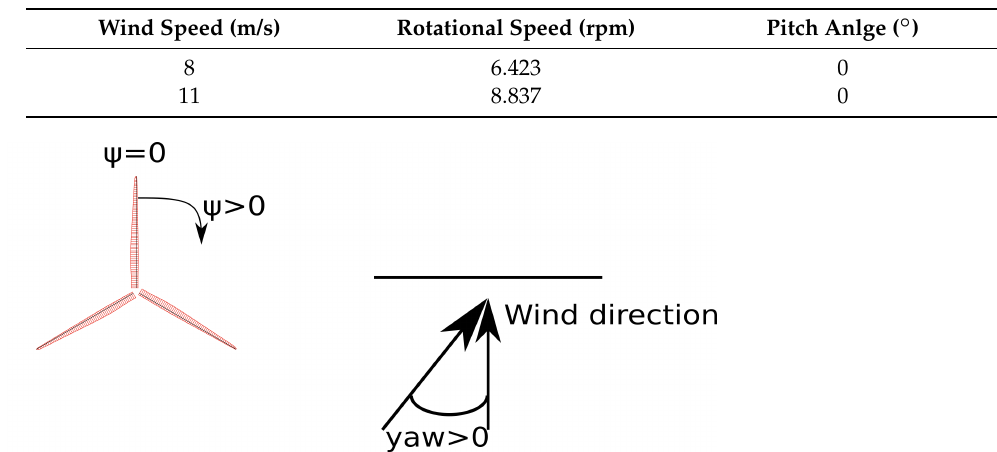
Table A1. INNWIND 10 MW operational data.